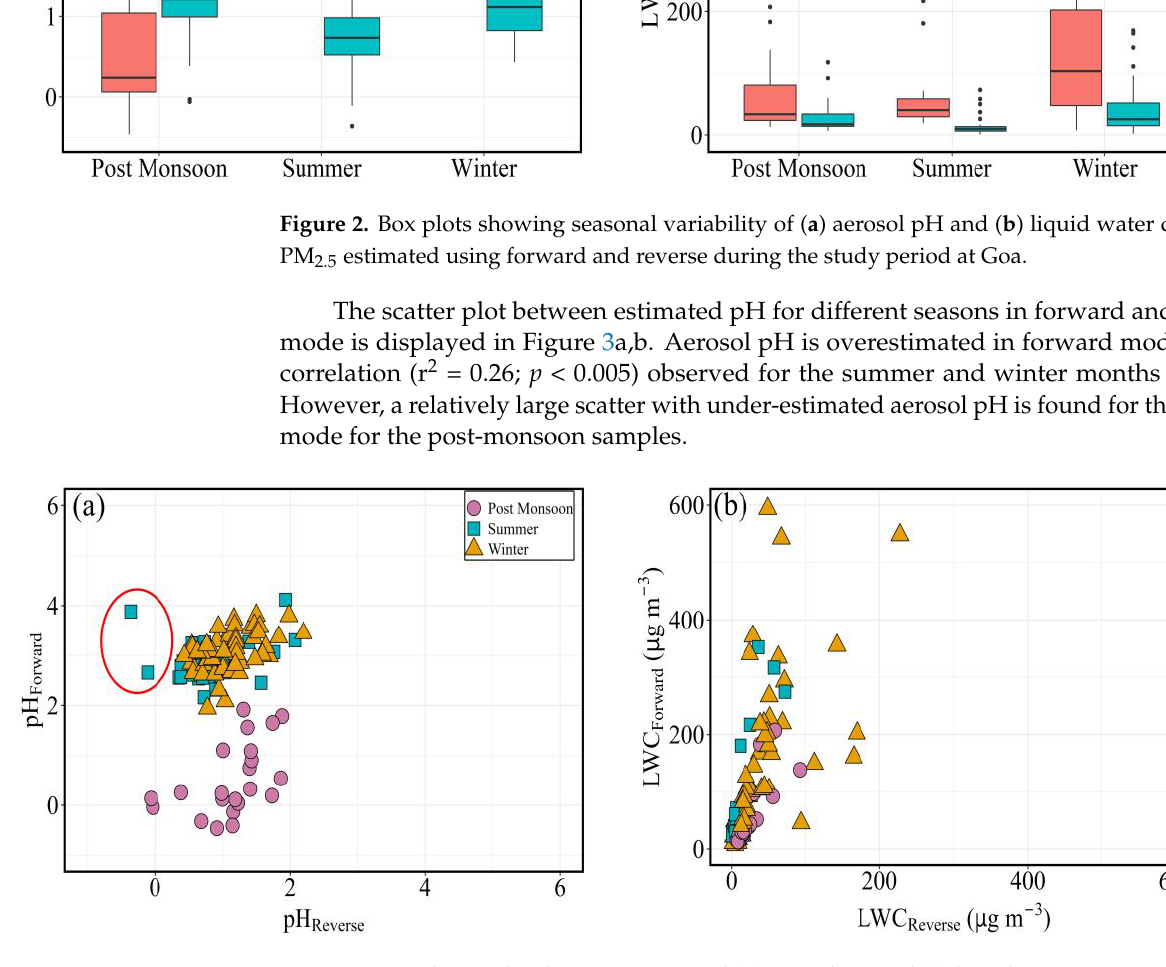
Figure 3. Correlation plots between estimated ( a ) aerosol pH and ( b ) liquid water content in forward and reverse mode of PM 2.5 during the study period at Goa. (outliers are in a circle and they are not used for correlation calculation).